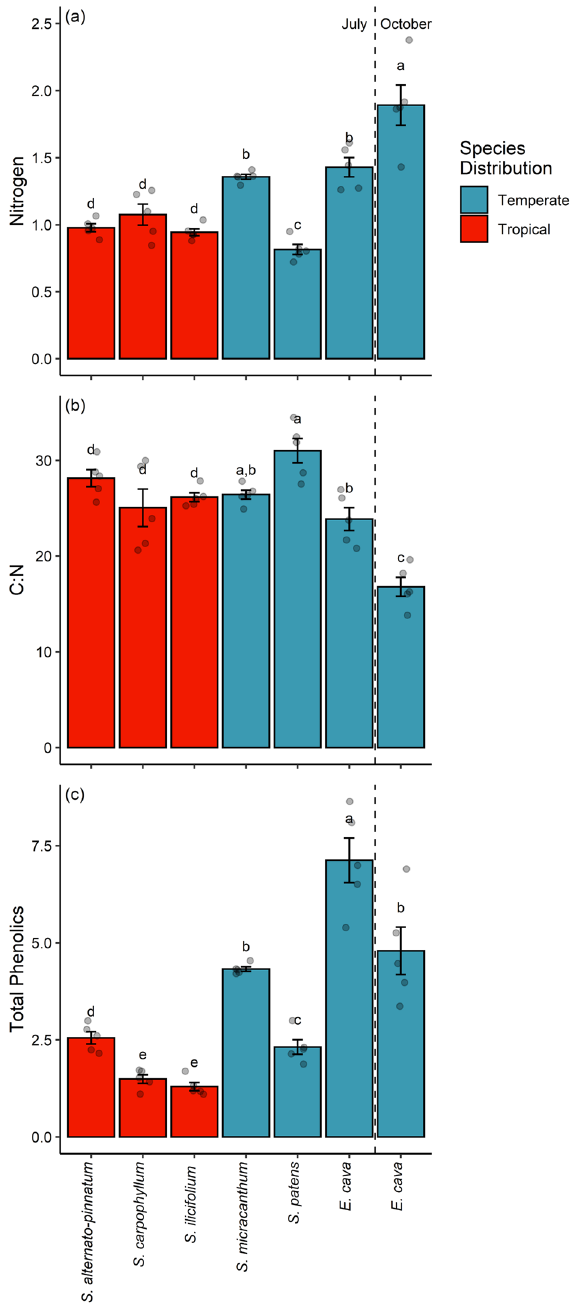
Figure 5. Nitrogen ( a ), C:N ratio ( b ) and total phenols ( c ) from each algal species in July and from Ecklonia cava in October. Bars that share a letter did not differ in Tukey’s post hoc tests contrasting algae from tropical and temperate